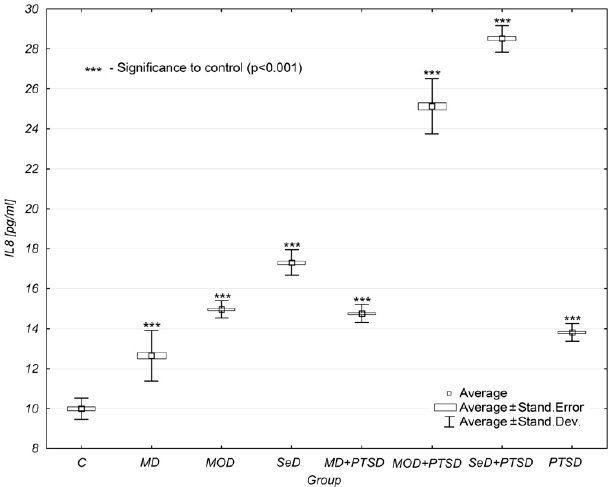
Figure 2. Mean IL-8 concentration levels in selected study groups. Legends: C—control group, MD—mild depression; MOD—moderate depression; SD—severe depression; MD + PTSD—mild depression + posttraumatic stress disorder; MOD+PTSD– moderate depression + posttraumatic stress disorder; SeD + PTSD—severe depression + posttraumatic stress disorder; PTSD—posttraumatic stress disorder; IL-8—interleukin-8. Number of patients in the study groups (females + males): C = 80, MD = 120, MOD = 120, SD = 120, MD+PTSD = 120; MOD+PTSD = 120; SeD + PTSD = 60; PTSD = 120. *** p < 0.005 when compared to the control group. Since all data was distributed normally, the one-way ANOVA test was used for statistical analysis (data is presented in the form of a box plot, which can be used to estimate differences in the mean values; the graphs show the mean and standard